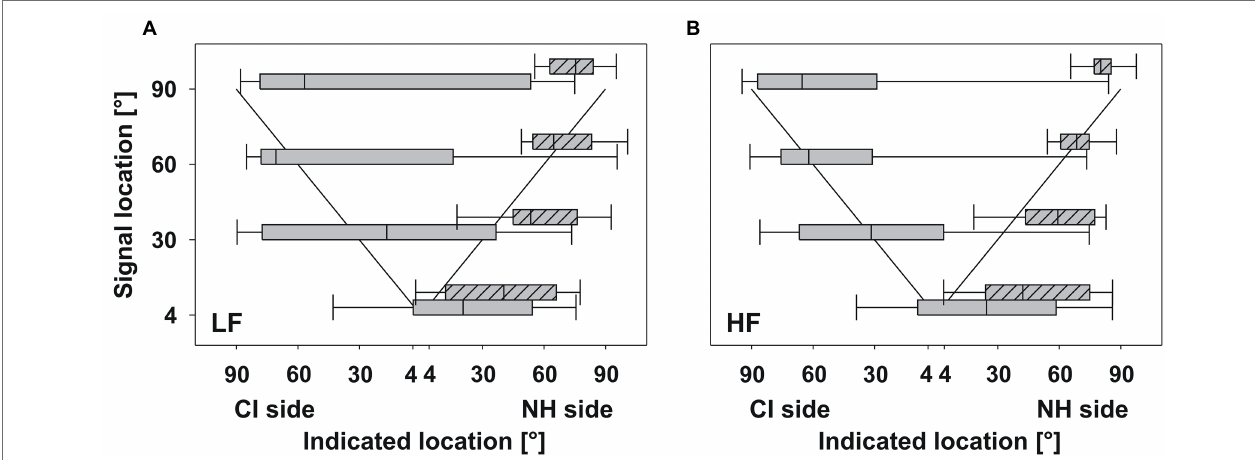
FIGURE 2 | Relative localization. The median across participants of indicated locations plotted against signal locations for (A) LF signals and (B) HF signals. For consistency across participants, results from the CI side are plotted on the left side of the abscissa, even if the CI was actually on the right side. The diagonal line shows 100% correct localization. Box plots show median (black line), 25th and 75th percentile (boxes), and 10th and 90th percentile (whiskers). Plain boxes indicate localized signals on the CI side, shaded boxes indicate localized signals on the NH side. On average, the group of SSD participants was able to localize the sounds, albeit with high variability.